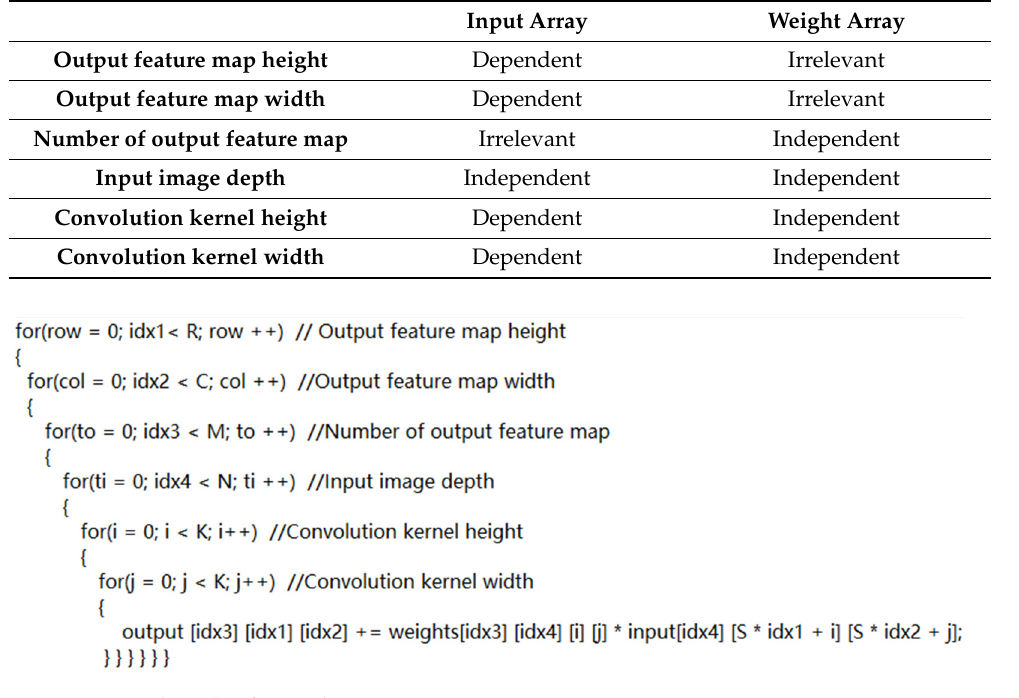
Figure 8. Pseudo code of convolution computing.